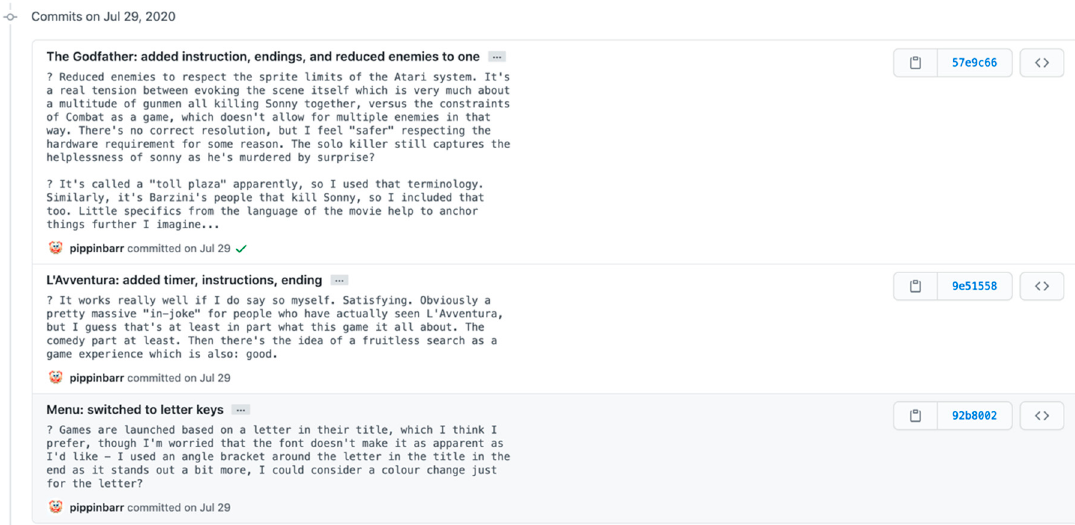
Figure 2. Design reflections in the code repository.